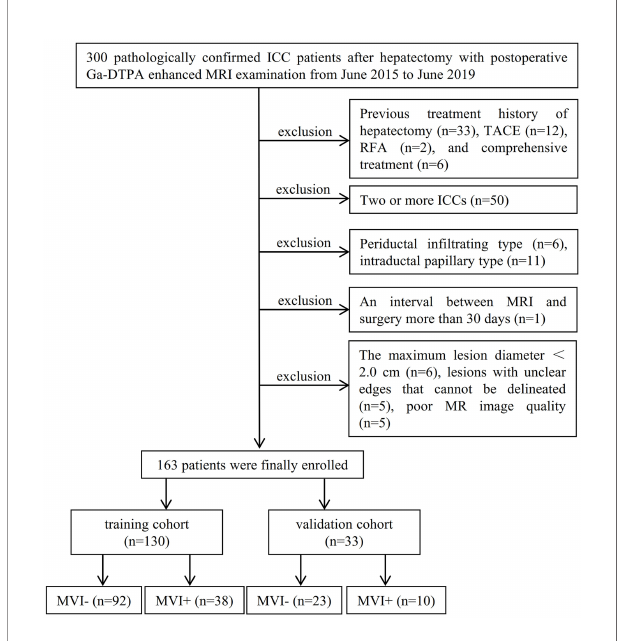
FIGURE 1 | Study fl owchart of the enrolled